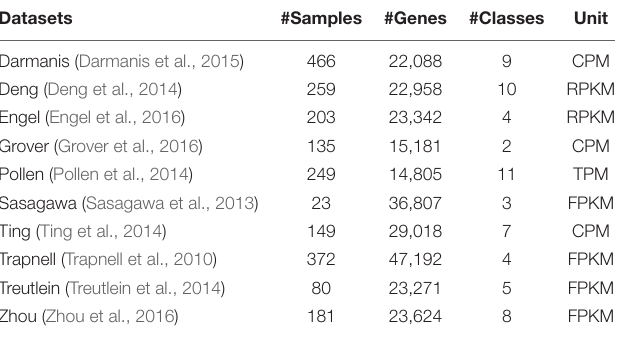
TABLE 1 | Summary description of the ten scRNA-seq datasets. Datasets